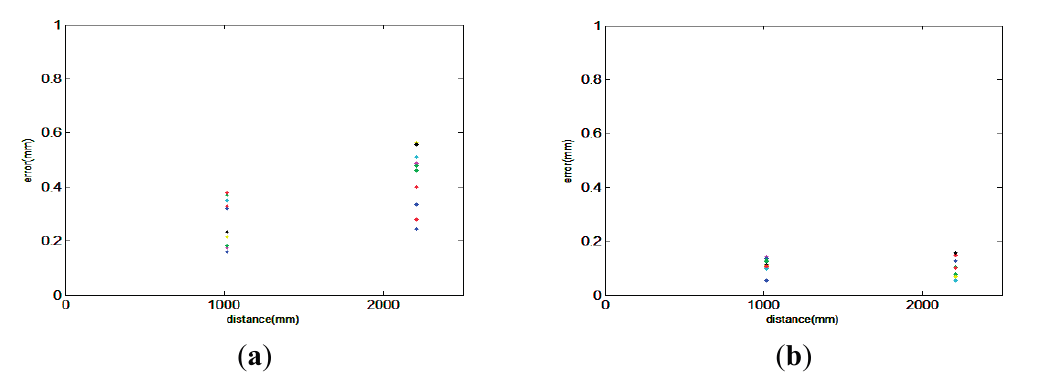
Figure 10. ( a ) Measurement error of AE and AF using the scanner; ( b ) Measurement error of AE and AF using the combined method.